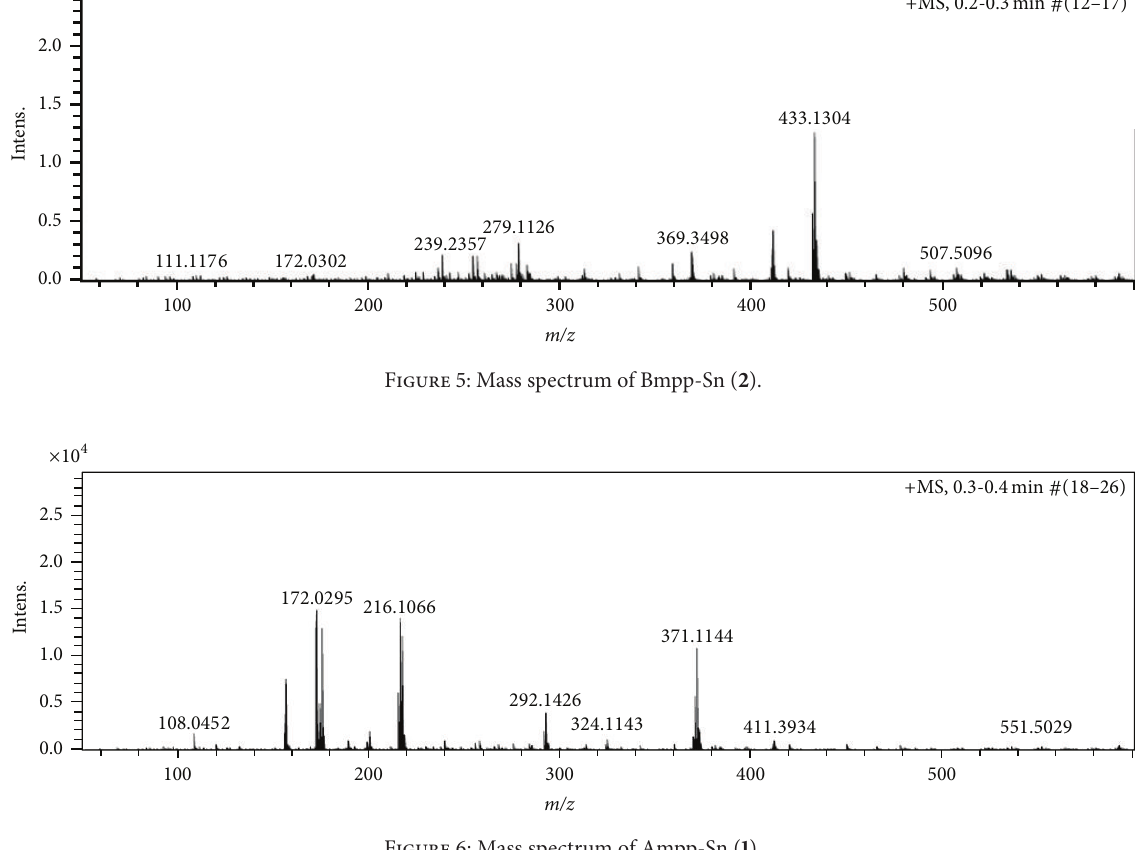
Figure 6: Mass spectrum of Ampp-Sn ( 1 ).